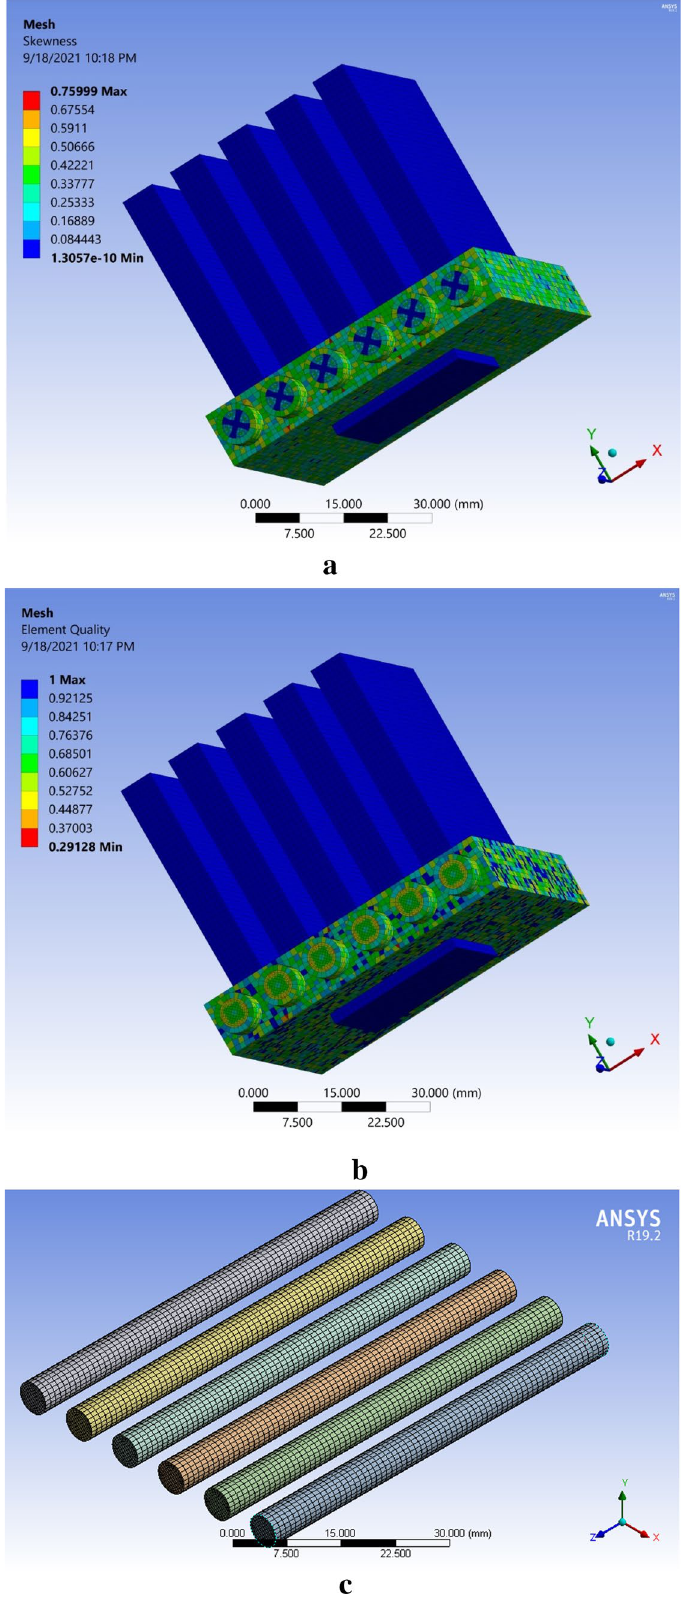
Figure 1. Mesh sketch, ( a ) skewness, ( b ) element quality, and ( c ) mesh of six